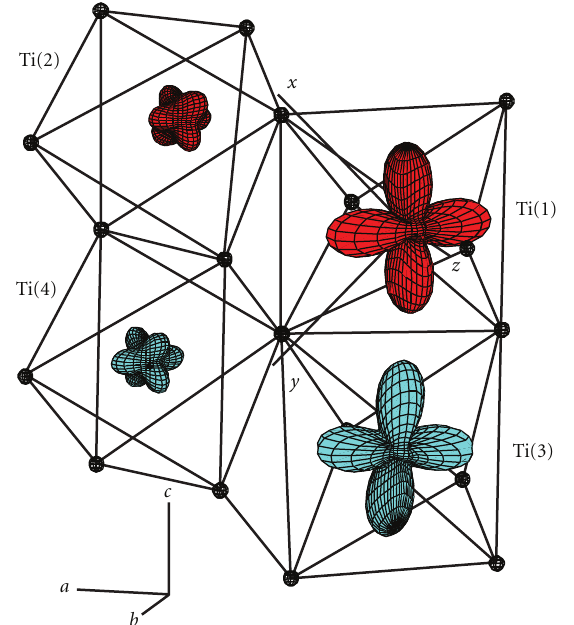
Figure 24: Structure of Ti 4 O 7 showing the angular distribution of the majority and minority spin 3 d electron density of Ti cations [187]. Red and cyan (light and dark, resp., on the black and white image) orbitals correspond to the majority and minority 3 d spin states, respectively. Oxygen atoms are shown by small spheres. The size of orbital corresponds to its occupancy. x - y - z coordinate system corresponds to the local cubic frame.